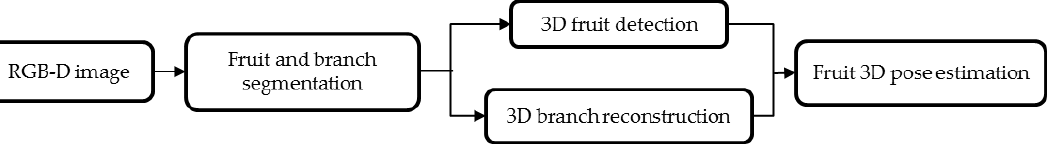
Figure 2. Flow diagram of the developed vision sensing algorithm.